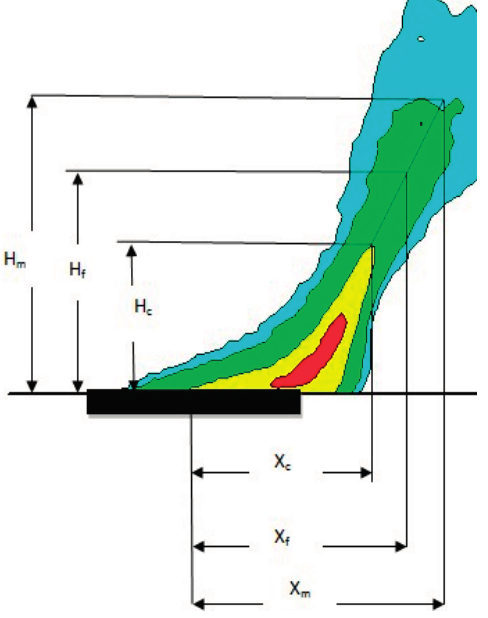
Figure 8. Pool fire in the crossflow and definition of the visible flame shape on the median plane.